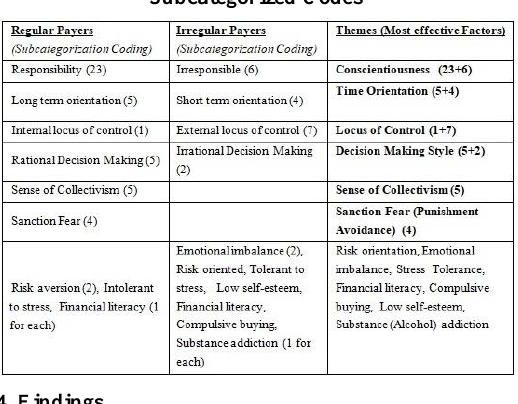
Table 3. Codes provided by Two-Step Coding Table 4. Themes Revealed by Refinement